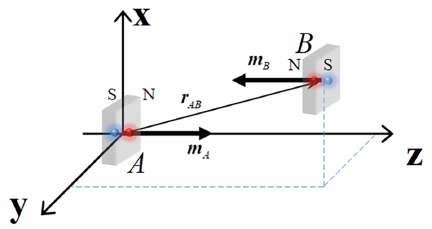
dipole – dipole model describes interaction between cuboid permanent